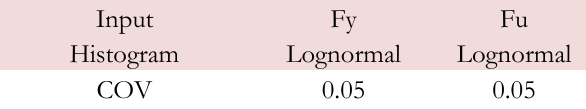
Table 7: Material properties in the stochastic modelling - steel.